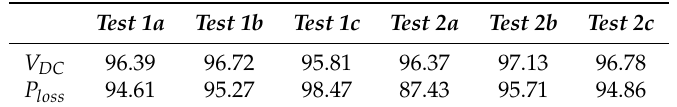
Table 5. Fidelity measures for the back-to-back (B2B)